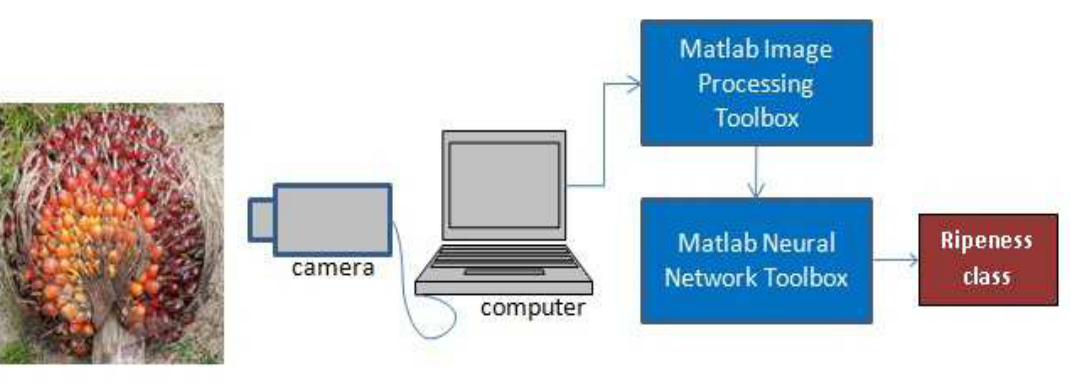
Figure 1. Oil palm FFB grading